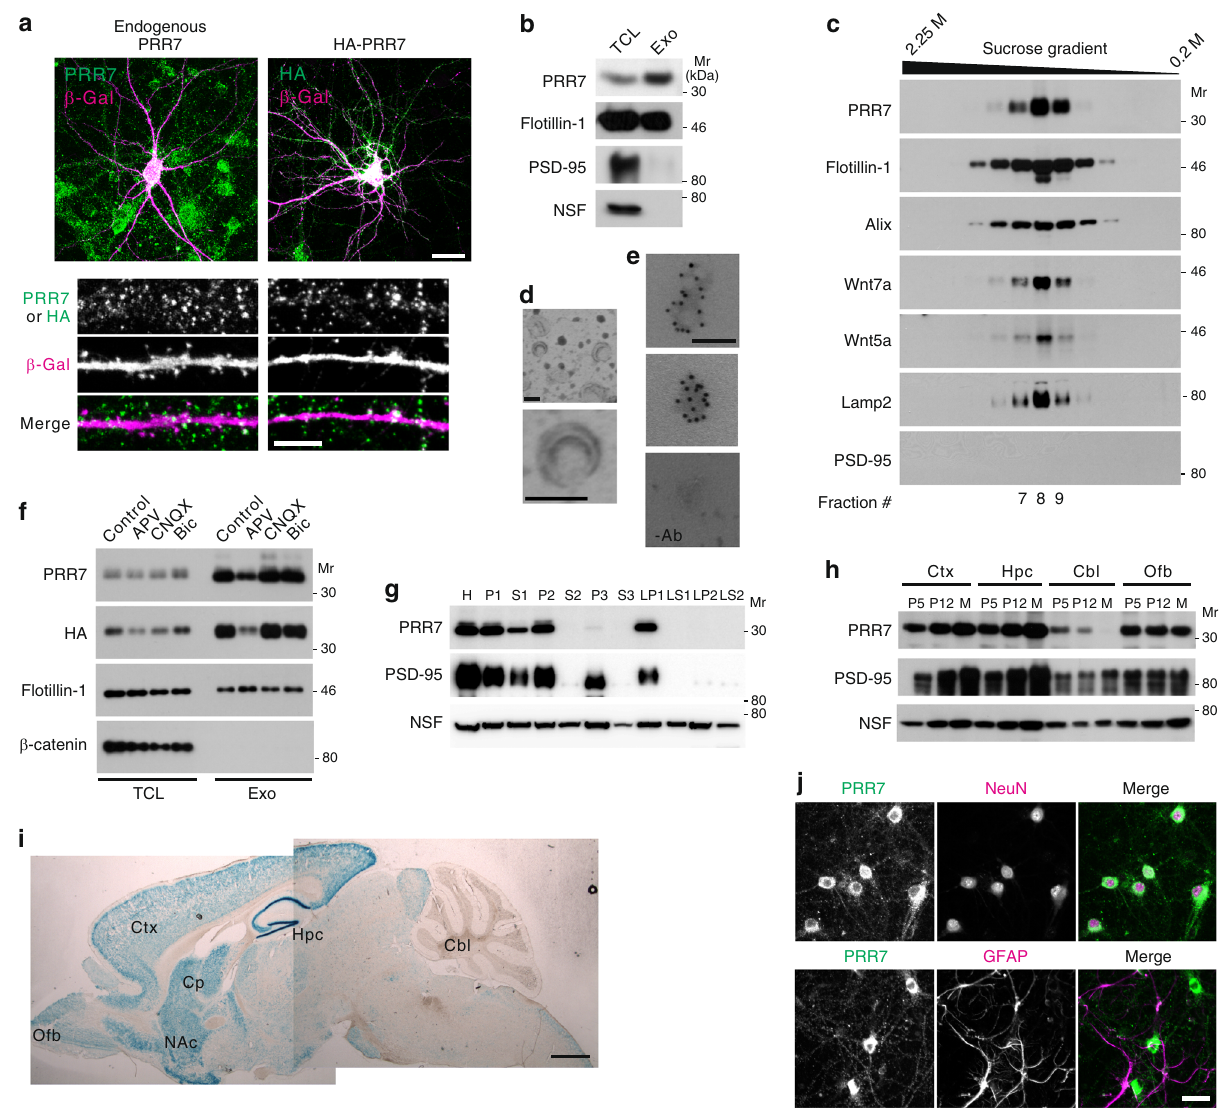
Fig. 1 Exosomal localization and expression patterns of PRR7. a Immuno fl uorescent images of endogenous PRR7 (left) and transfected HA-PRR7 (right) in dissociated hippocampal neuron culture. β -Gal was used as a neuronal- fi ll marker. Scale bars, 20 (top images) and 5 μ m (bottom images). b Enrichment of PRR7 in exosome preparation puri fi ed from the supernatant of hippocampal neuron culture. Exo exosomes, TCL total cell lysate. c Sucrose density gradient centrifugation analyses of PRR7-containing exosomes. d Electron micrographs of the PRR7-enriched fraction (#8) showing the typical cup-shaped vesicular structure of exosomes. e Immuno-EM images showing HA-positive immunogold particles on exosomes (top two panels; showing two exosomes and single exosome, respectively). A negative control image obtained in the absence of antibody ( − Ab) is shown at the bottom. Scale bars ( d , e ), 100 nm. f Activity- dependent secretion of PRR7 on exosomes. g Distribution of PRR7 in various subcellular fractions of mature rat forebrain tissues. H total homogenate, P1 cell debri and nuclear pellet, S1 postnuclear supernatant, P2 synaptosomal fraction, S2 supernatant of P2, P3 microsomal pellet, S3 soluble fraction, LP1 synaptosomal membrane-enriched pellet, LP2 synaptic vesicle-enriched fraction, NSF n -ethylmaleimide-sensitive factor. h Developmental changes of PRR7 protein expression in various regions of the rat brain. Ctx cortex, Hpc hippocampus, Cbl cerebellum, Ofb olfactory bulb, P5 postnatal day 5, M 3- month old mature rats. i Expression pattern of PRR7 as determined by β -Gal staining of brain sections from adult PRR7 KO mice with β -Gal reporter knock- in. Cp caudate putamen, NAc nucleus accumbens. Scale bar, 1 mm. j Immuno fl uorescent images showing neuron-speci fi c expression of PRR7 in rat hippocampal neuron culture. Scale bar, 20 μ m. Mr relative molecular the effect of PRR7 on excitatory synapses in neighboring by short hairpin RNA (shRNA)-mediated RNA interference non-transfected neurons (Nxf). Strikingly, PRR7 overexpression (RNAi; for speci fi city see Supplementary Fig. 2g – k) produced the also reduced the number of excitatory synapses in Nxf (Fig. 2a – d opposite effects on excitatory synapses (Fig. 2e – h and Supple- and Supplementary Fig. 2a – f), suggesting that PRR7 has non-cell mentary Fig. 2l). In addition, co-overexpression of shRNA- autonomous effects. In contrast, PRR7 with C-terminally fused resistant PRR7 (Supplementary Fig. 2g) completely abolished the green fl uorescent protein (EGFP) (PRR7-GFP) showed reduced RNAi effect on PSD-95 puncta (Fig. 2h), demonstrating PRR7- synapse-eliminating activity in Txf compared to HA-PRR7 and is speci fi c effect of the RNAi. Consistent with the loss of excitatory virtually devoid of the non-cell autonomous effect (Fig. 2a – d and synaptic markers, PRR7 overexpression also greatly reduced the Supplementary Fig. 2b – c). On the other hand, PRR7 knockdown number of dendritic spines in Txf (Fig. 2i, j).